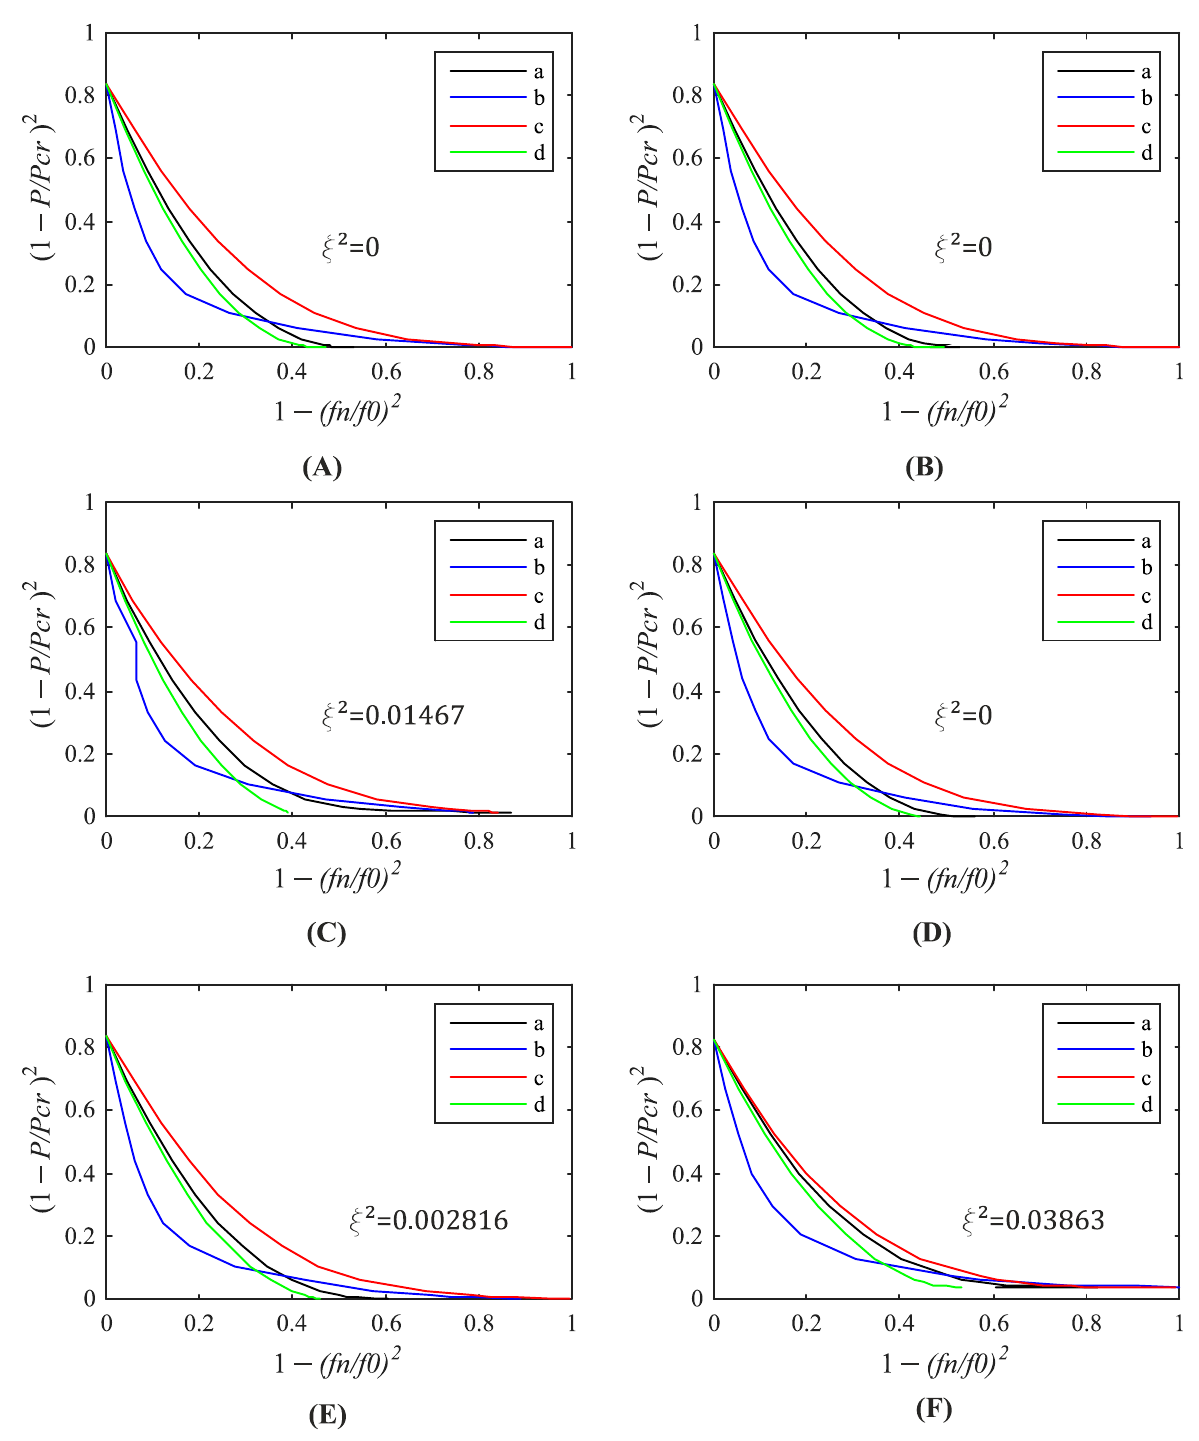
Figure 12. Relationship between relative load and natural frequencies ((a) first, (b) second, (c) third, (d) fourth) of the silo segment with initial geometrical imperfections: ( A ) F1_2 mm, ( B ) F1_5 mm, ( C ) F1_20 mm, ( D ) F2_2 mm, ( E ) F2_5 mm, ( F ) F2_20 mm, according to the modified VCT by Arbelo. Table 2. Arbelo method results.